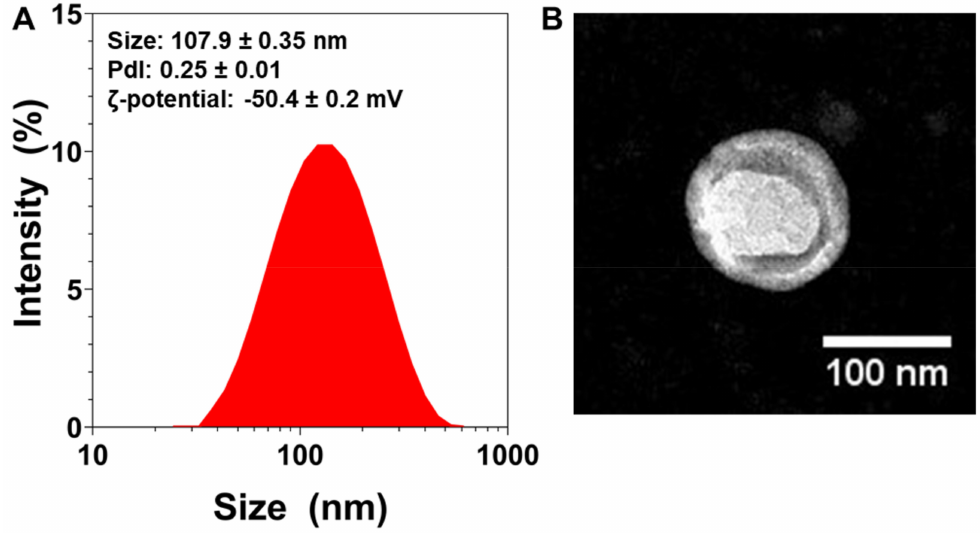
Figure 1. Physicochemical characterization of nanoliposomes (NL): ( A ) Size distribution measurements of NLs measured via dynamic light scattering, with average size, polydispersity index (PDI), and zeta-potential values ( n = 3). ( B ) TEM images of